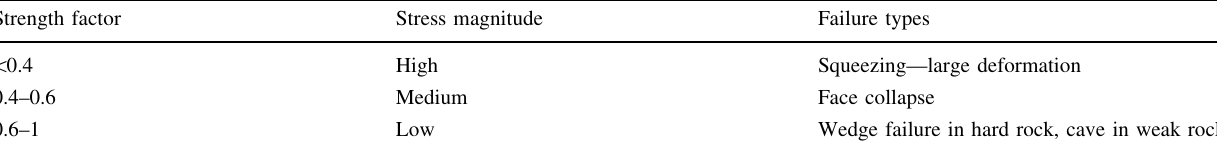
Table 6 Instability mechanism in terms of strength factor Strength